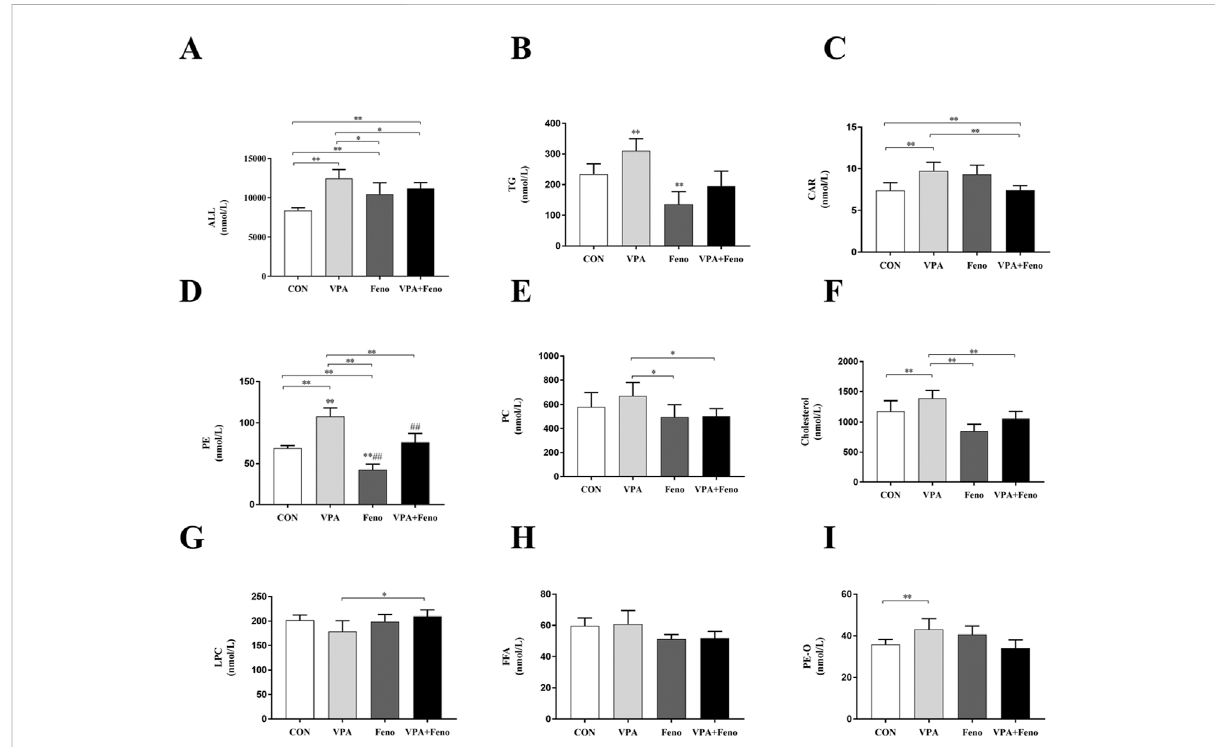
FIGURE 10 Changes intotallipid andsubclasscontent betweenfourgroups. (A) Total lipid content; (B) TG (C) CAR (D) PE (E) PC (F) Cholesterol (G) LPC (H) FFA (I) PE-O levels; CON: control group; VPA: VPA 500 mg/kg group; Feno: Feno50 mg/kg group; VPA + Feno: VPA 500 mg/kg + Feno50 mg/kg group; *p < 0.05, **p < 0.01. TG: triglycerides, CAR: acylcarnitine, PE: phosphatidylethanolamine, PC: phosphatidylcholine, LPC: lysophosph- atidylcholine, FFA: free fatty